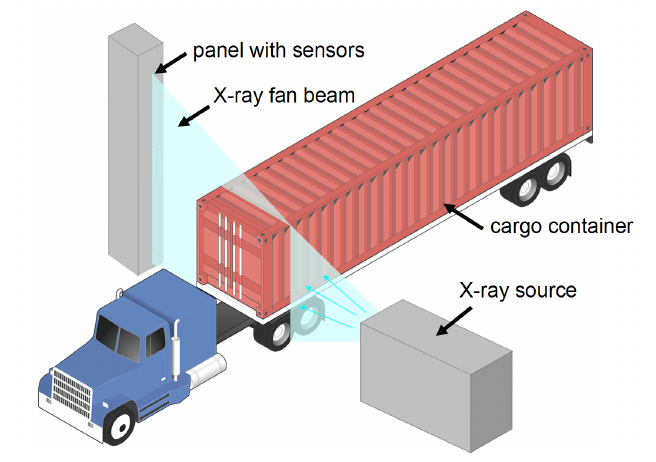
Figure 1. Conventional high energy X-ray cargo inspection system with material discrimination (similar to, e.g.,